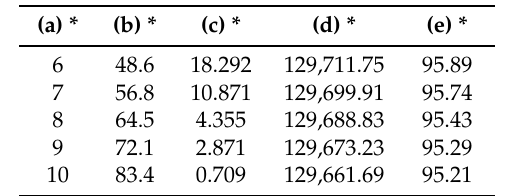
Table 2. Results of using the RSONP algorithm to solve the RSONP problem on the IEEE 118-bus system in Case